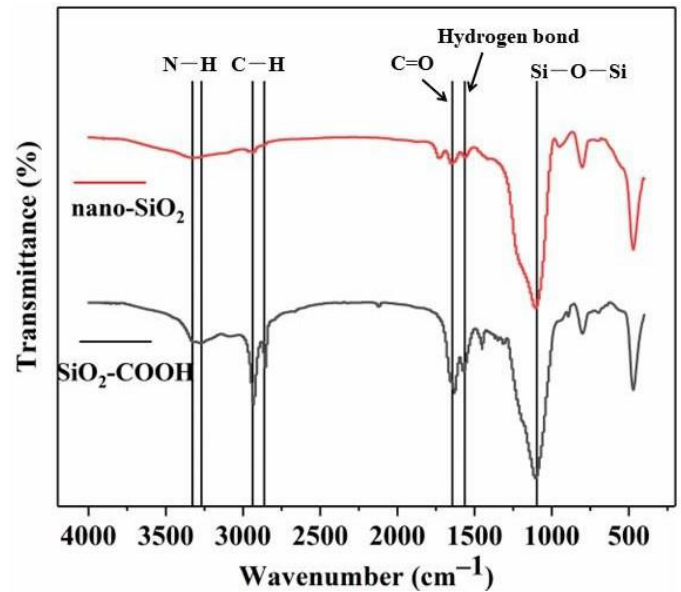
Figure 3. Infrared spectra of nano-SiO 2 and SiO 2 -COOH.